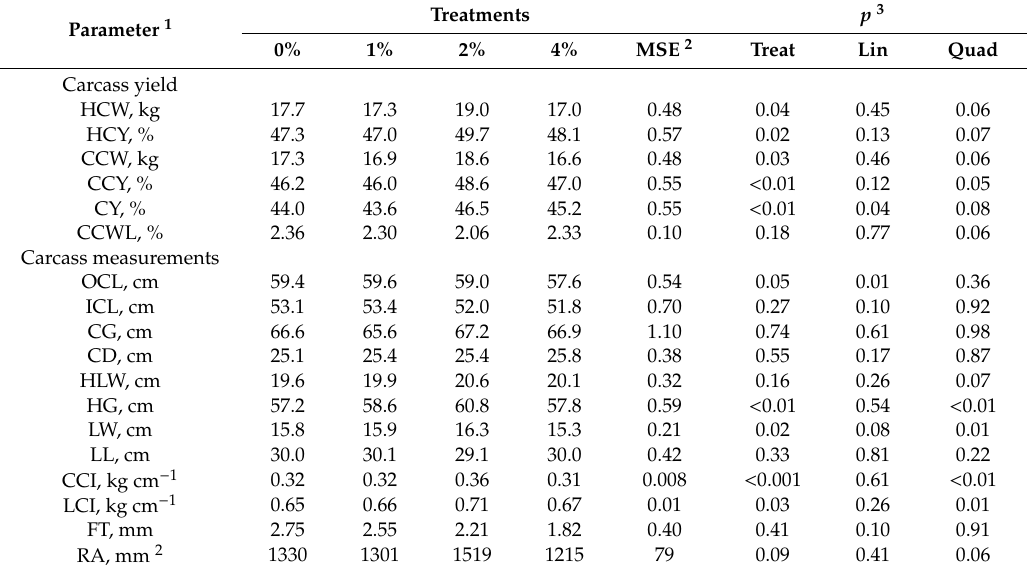
Table 5. Carcass traits of growing lambs fed increased levels of yerba mate